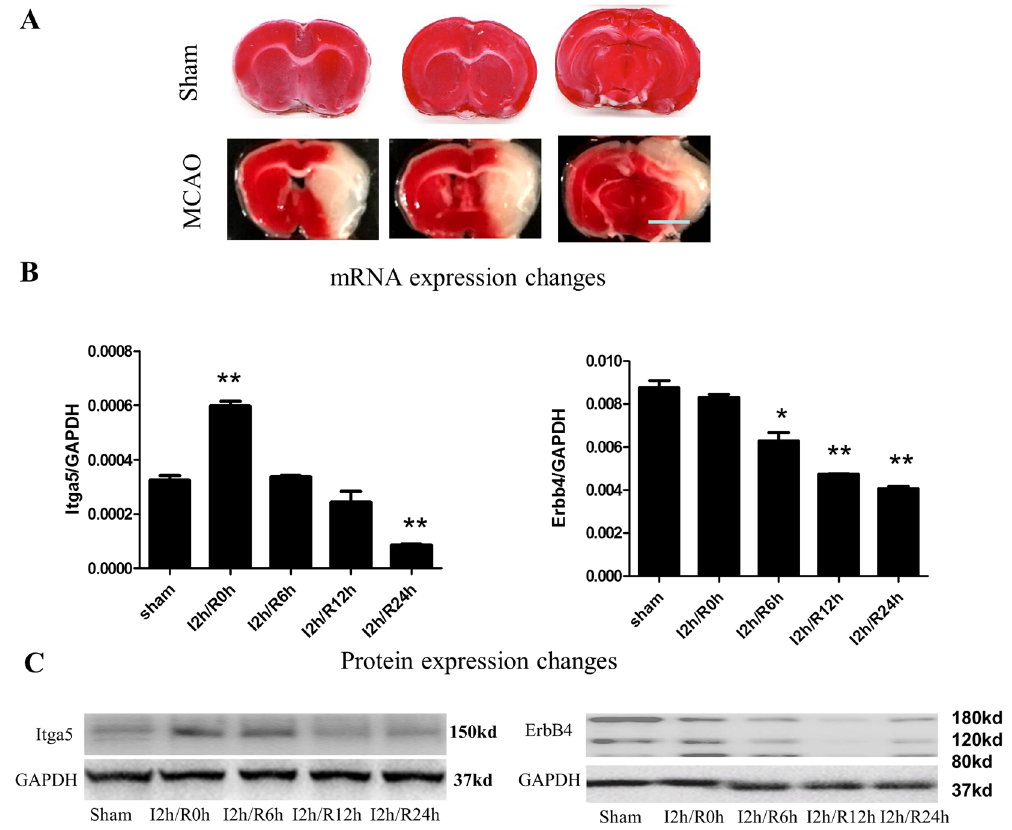
Figure 5. Validation of identified key gene expression changes after ischemic stroke (MCAO) ( A ) Representative images of TTC staining showing the infarct area in sham control or MACO treated animals. Scale bar: 1 mm. ( B , C ) mRNA (qRT-PCR) and protein (western blotting) expression changes of two identified key genes (Itga5 and ErbB4) at various time points after ischemic stroke (MCAO). ** p < 0.01, One-way ANOVA followed by Bonferroni post hoc correction (against sham control), n = 3 for each time points (samples were pooled from 4 animals for individual time points) for sham, 12 h/R 0 h, 12 h/R 6 h, 12 h/R 12 h, and 12 h/R 24 h